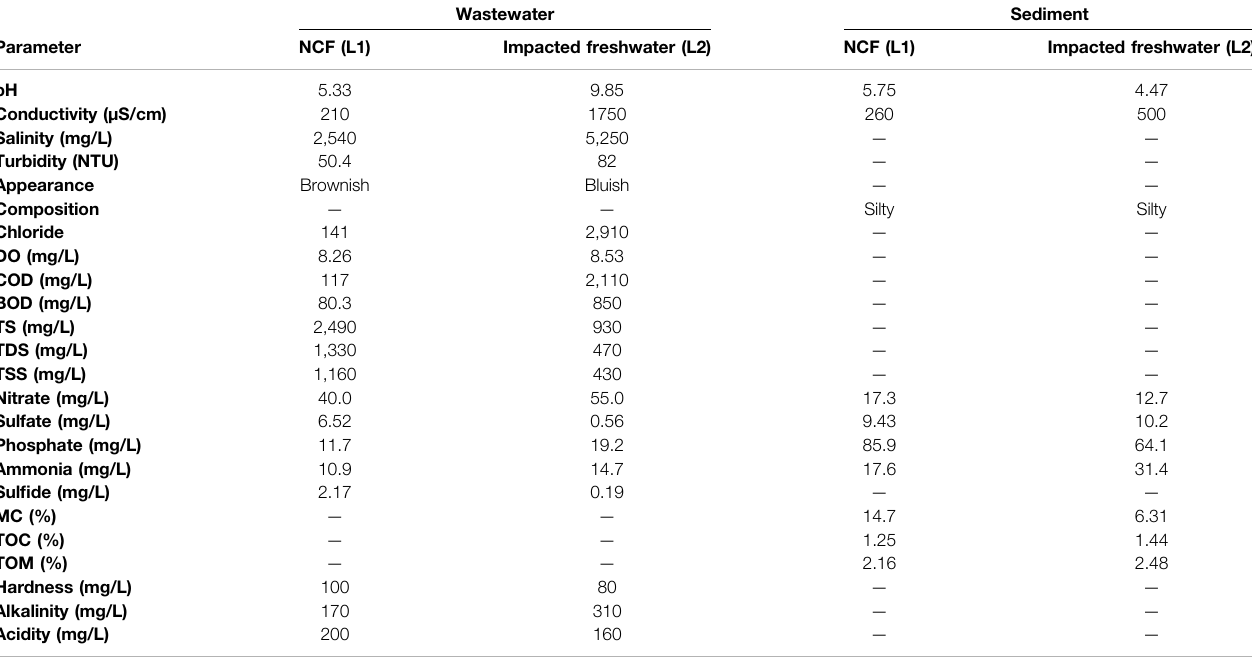
TABLE 1 | Physicochemical status of the impacted freshwater receiving textile wastewater and a pristine